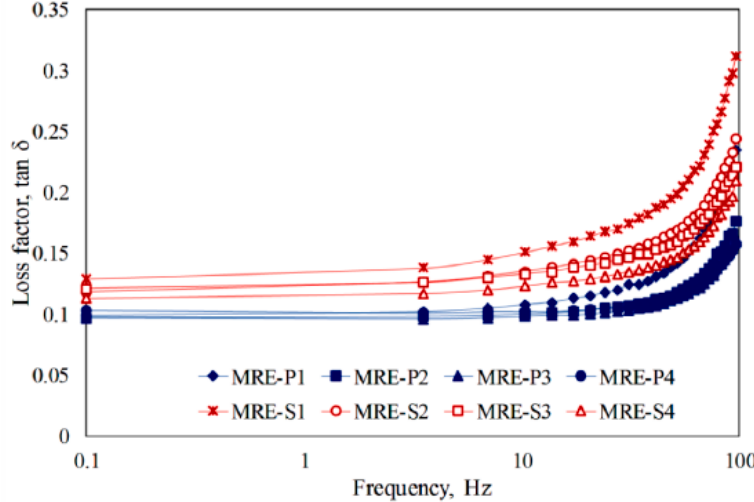
Figure 5. Frequency dependence of loss factor with di ff erent curing magnetic fields and particle shapes [115].